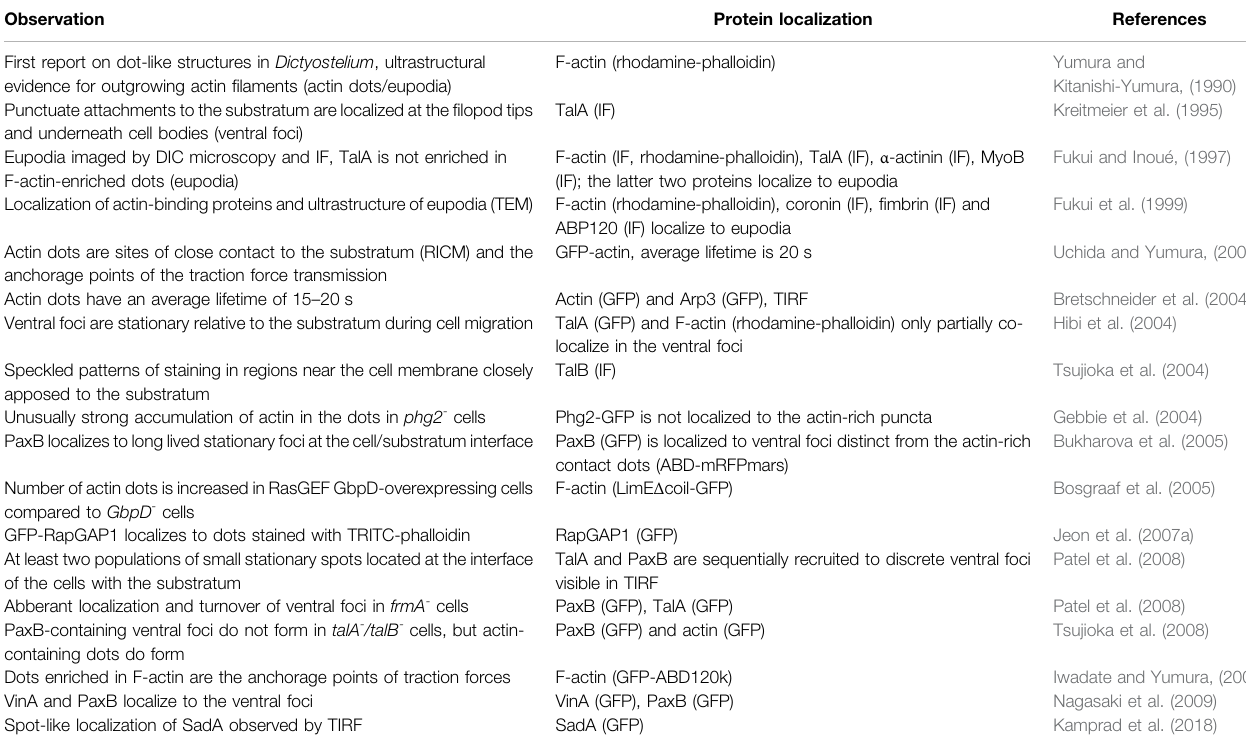
TABLE 1 | Reported observations and composition of punctuate structures at the cell-substratum interface in Dictyostelium cells in chronological order. Abbreviations: IF — immuno fl uorescence; DIC — differential interference contrast; TEM — transmission electron microscopy; GFP — green fl uorescent protein; TIRF — total internal related protein three; PaxB — paxillin B; RasGEF — Ras guanine nucleotide-exchange factor; RapGAP1 — Rap GTPase-activating protein one; VinA — vinculin A; CtxI — cortexillin